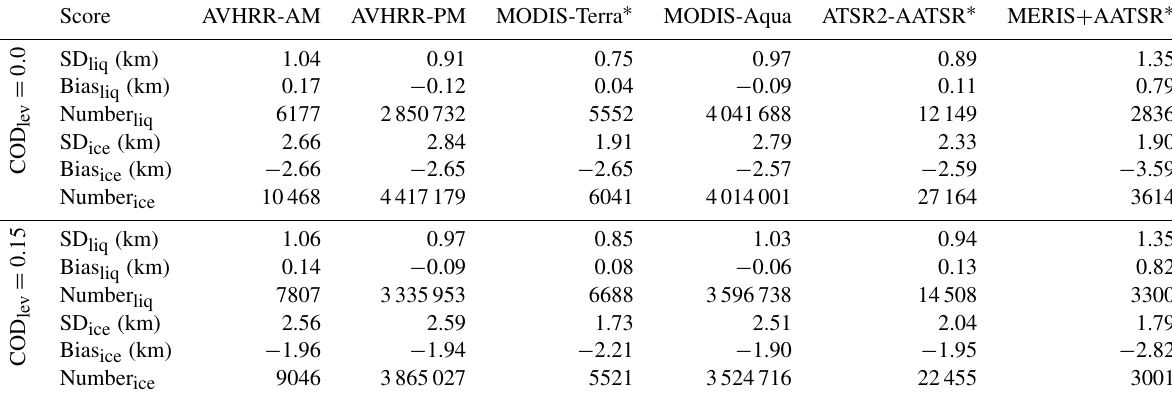
Table 8. Summary of cloud-top height (CTH) validation results for Cloud_cci datasets when compared against CALIOP. Validation measures are standard deviation (SD) and bias. Also given is the number of collocated pixels. All scores are separated into liquid and ice clouds (both Cloud_cci dataset and CALIOP had to agree on phase) and into two cloud optical depth levels (COD lev ) representing at which top-down COD into the cloud the reference CALIOP CTH was